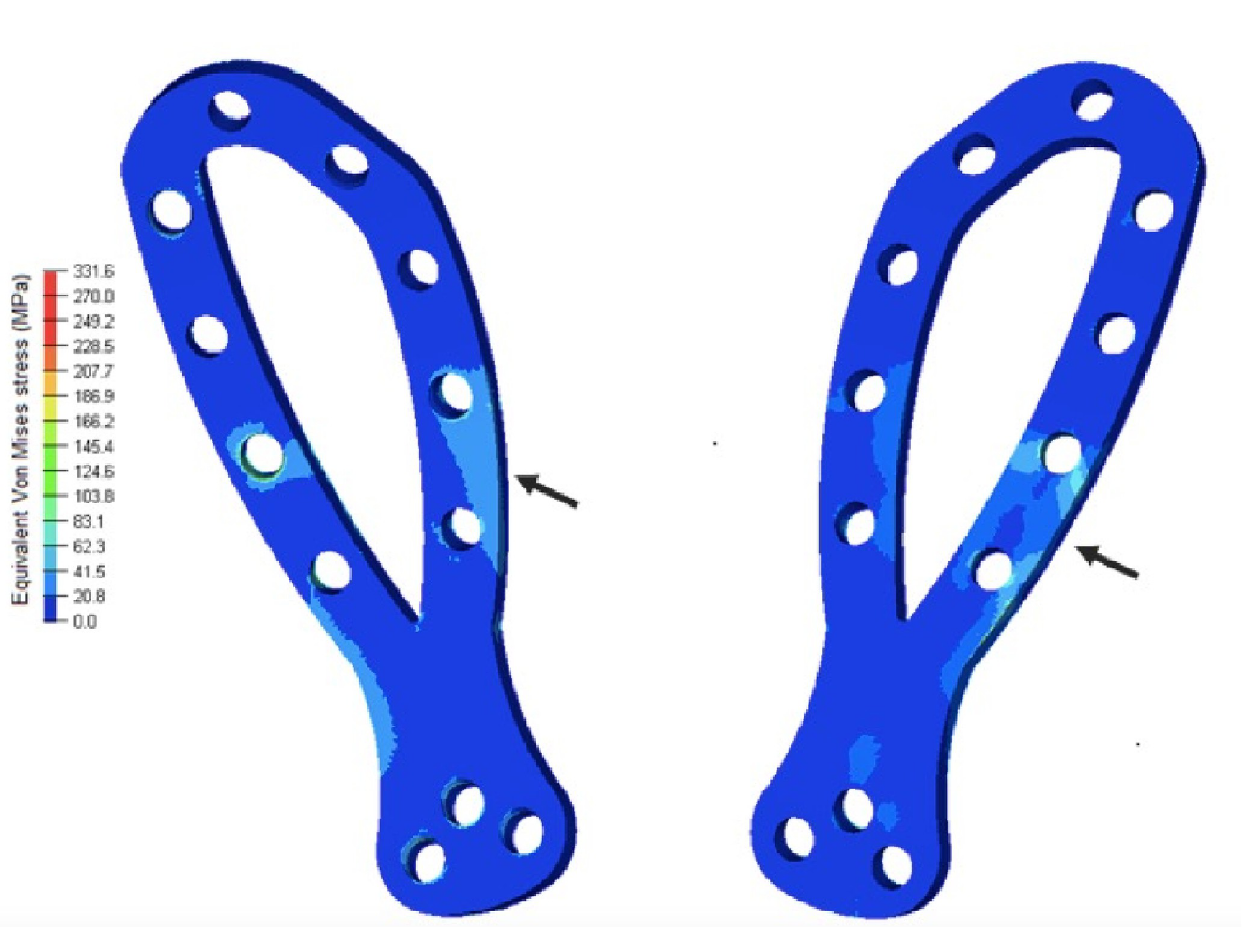
PLOS ONE | https://doi.org/10.1371/journal.pone.0269313 August 26,